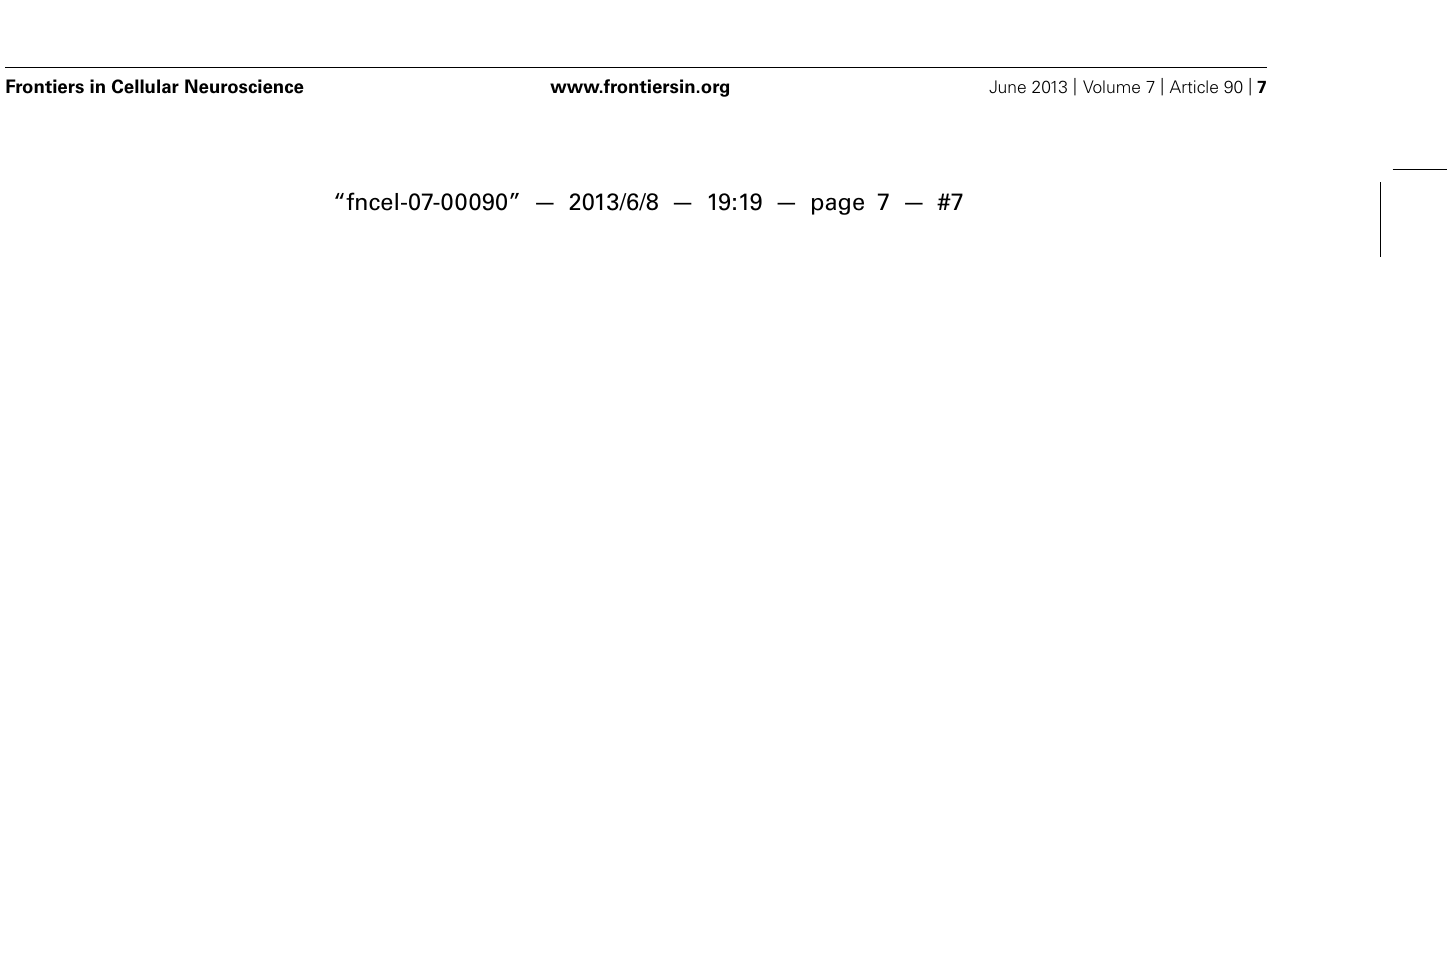
FIGURE 4 |Associations between clinical improvement at 4 weeks and ratio of uric acid to guanine in first-episode neuroleptic-naïve patients with schizophrenia at baseline (A) or at 4-week (B) after antipsychotic treatment. GAS, Global Assessment Scale; ln, natural logarithm. Reprinted by permission fromYao etal.